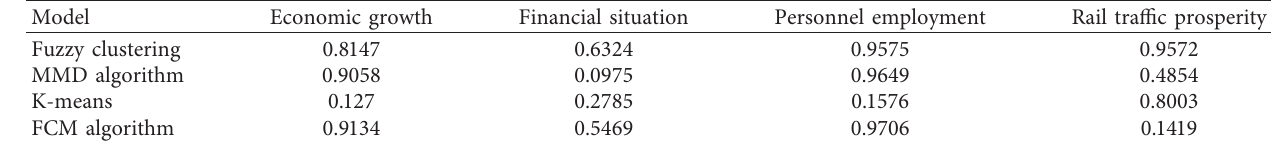
Table 4: The growth level of the regional economy and the development of the railway